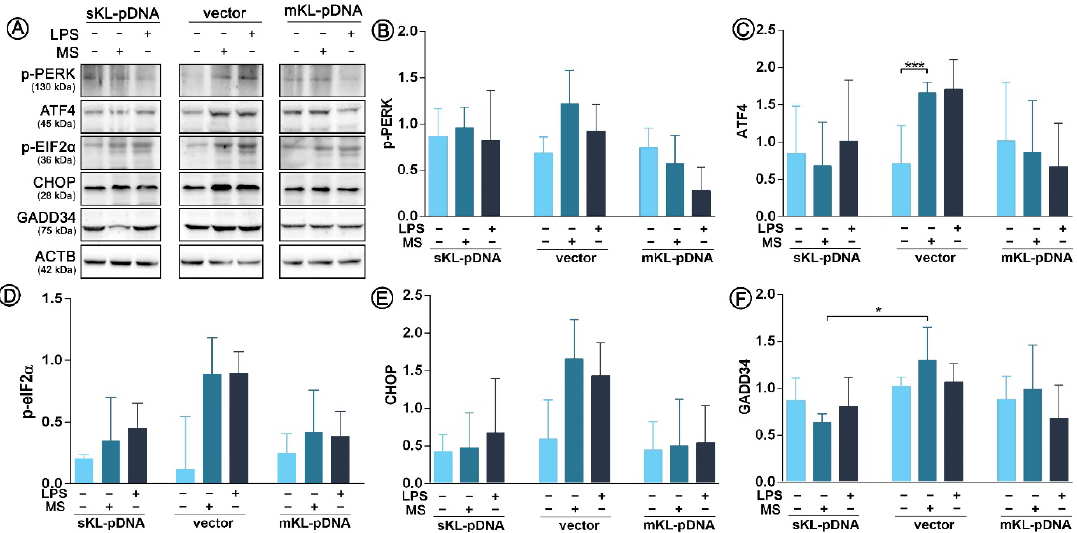
Figure 5. Expression of factors involved in ER stress response. Klotho expression was upregulated with pDNA, cells were treated for 72 h with monensin sodium or 168 h with LPS and expression of proteins involved in PERK-mediated pathway was evaluated with Western Blot method ( A ), i.e.,: p-PERK ( B ), ATF4 ( C ), p-eIF2 α ( D ), CHOP ( E ), and GADD34 ( F ). The bands were quantified and normalized to their corresponding β -actin bands. Bars indicate SD, n = 3, *** p < 0.001, * p < 0.05, no indication – no statistical significance (one-way ANOVA and Dunnett’s a posteriori test).